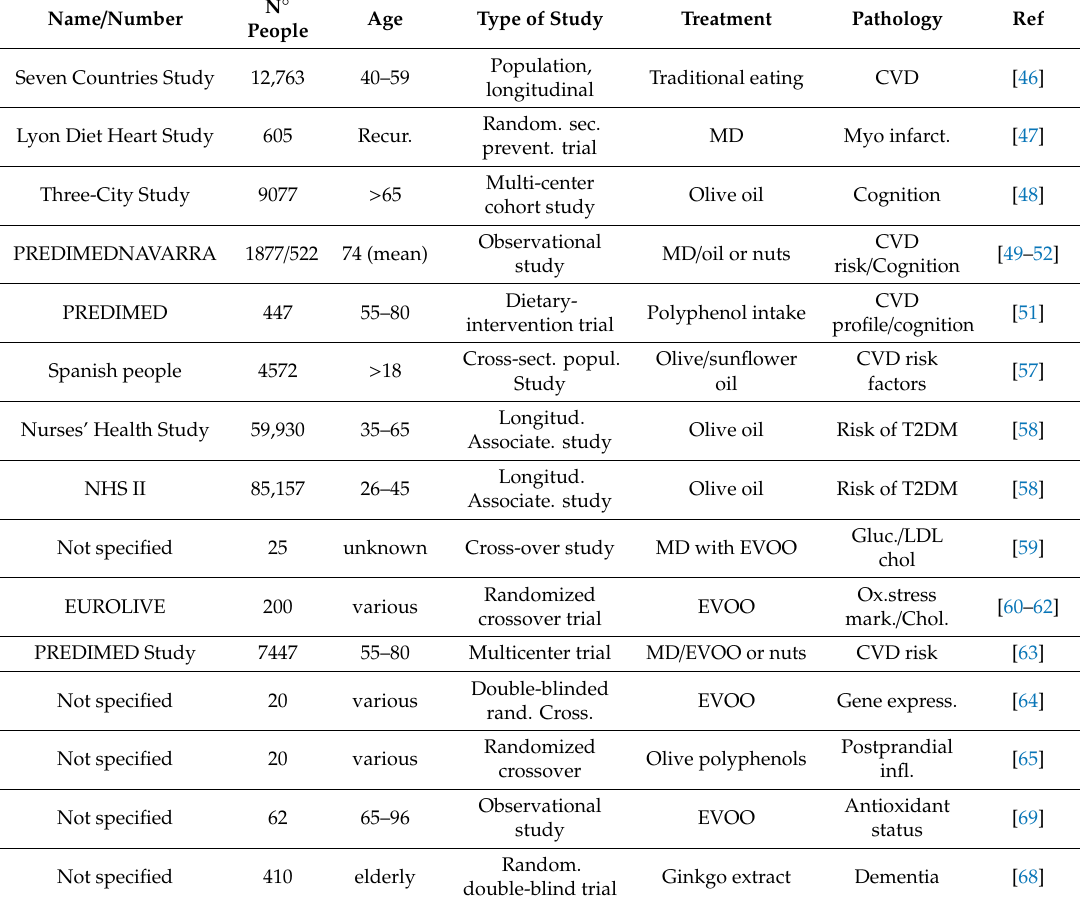
Table 1. A list of relevant population studies and clinical trials carried out with plant polyphenols or polyphenol-enriched